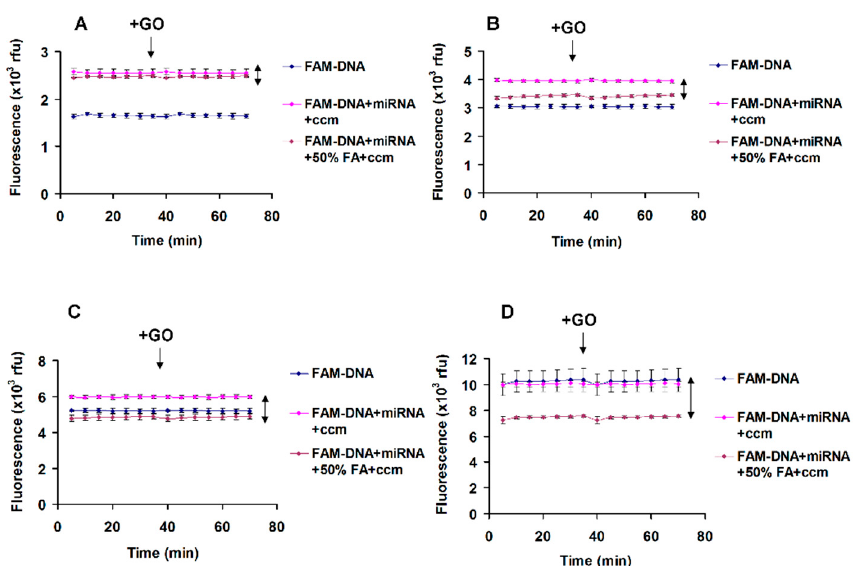
Figure 3. Detection of microRNA (18 nt) spiked-in cell culture medium (ccm). ( A ) 1 nM, ( B ) 2 nM, ( C ) 4 nM, ( D ) 8 nM microRNA. The microRNA detection is done by fluorescence quenching due to PET using complementary FAM-DNA fluorescent probe (double arrow). The experiments were done in triplicate samples. Error bars represent the standard deviations of triplicate values.